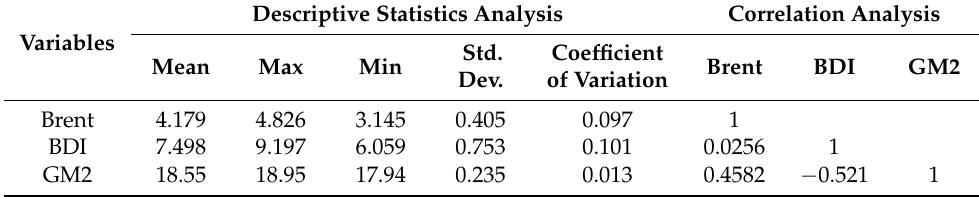
Table 1. Descriptive